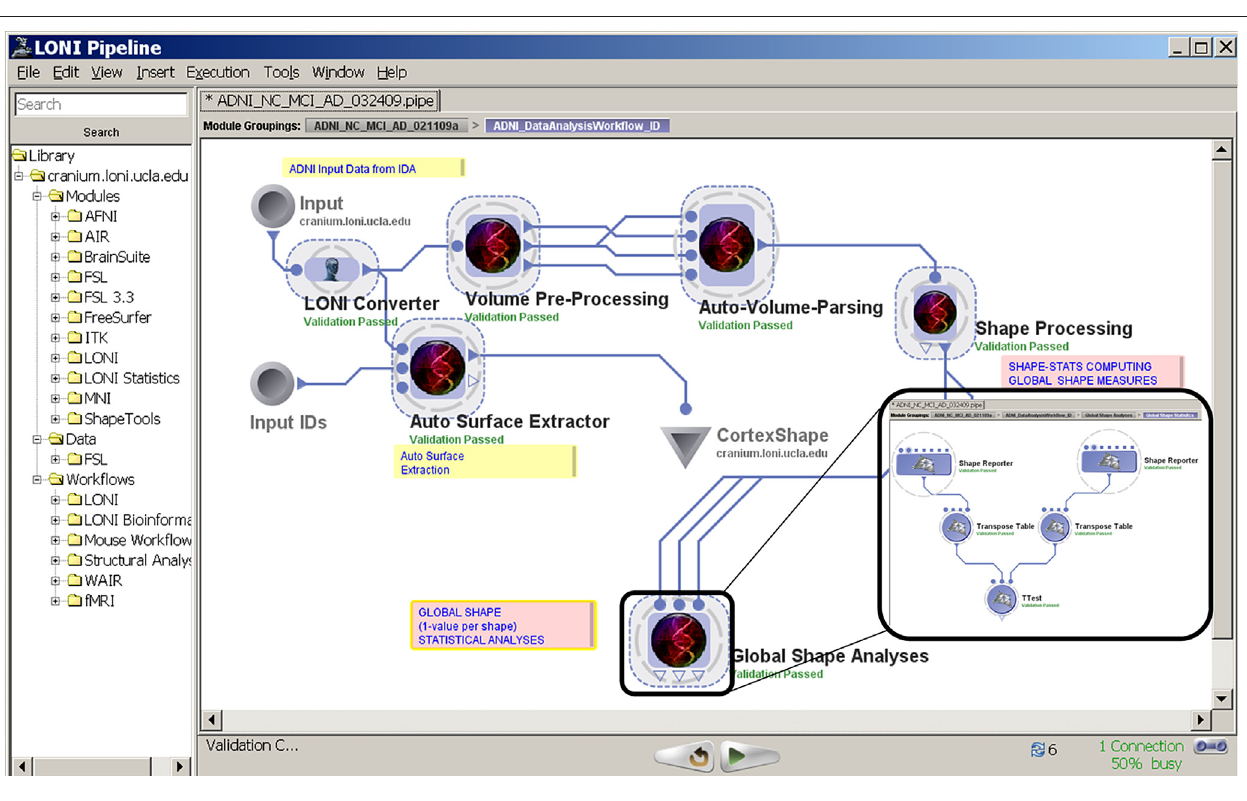
FIGURE 4 | An Alzheimer’s Disease (AD) Pipeline workfl ow. The left-panel contains some predefi ned Pipeline module defi nitions including some complete workfl ows. The central-panel shows the main six steps of the data analysis – data conversion, pre-processing, automated extraction of regions of interest, shape processing, global shape analysis and